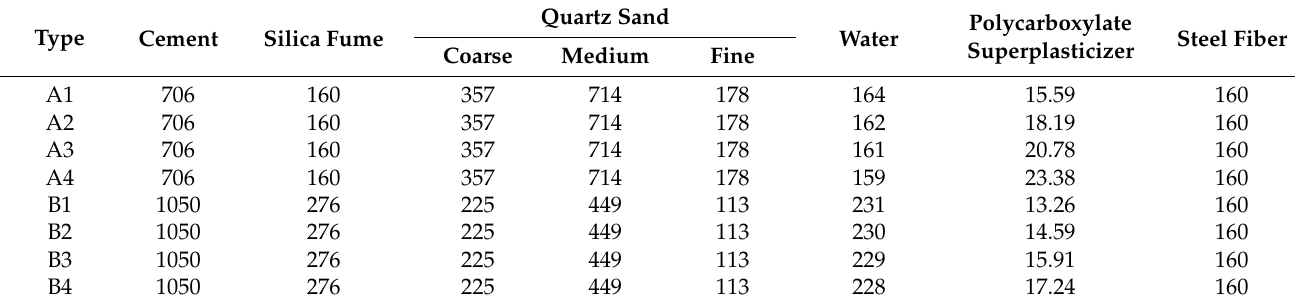
Table 1. Mix proportions of UHPC (kg · m − 3